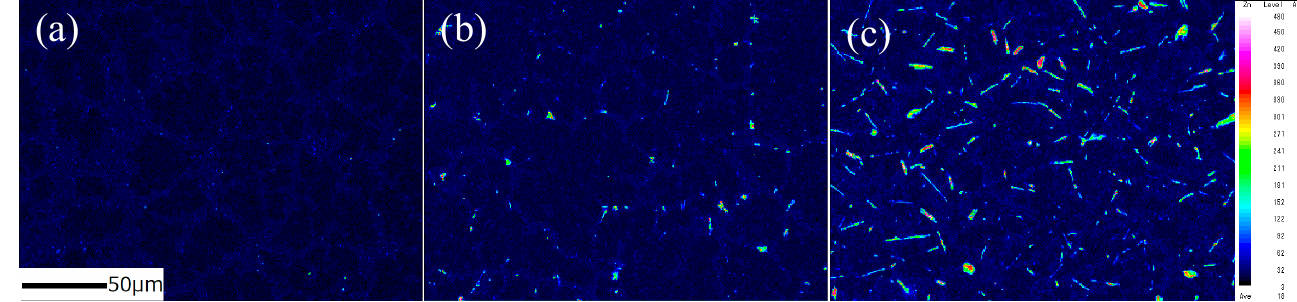
Figure 5. EPMA mapping images of Zn in ( a ) Sn-40Bi-0.1Zn, ( b ) Sn-40Bi-1.0Zn, and ( c ) Sn-40Bi-3.0Zn.